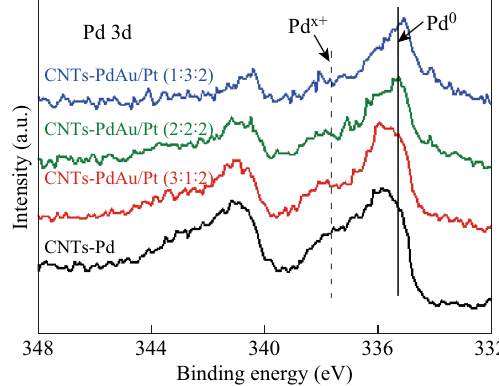
Fig. 5 Pd 3 d XPS spectra of CNTs-supported PdAu/Pt trimetallic NPs with different Pd/Au/Pt ratios and Pd NPs